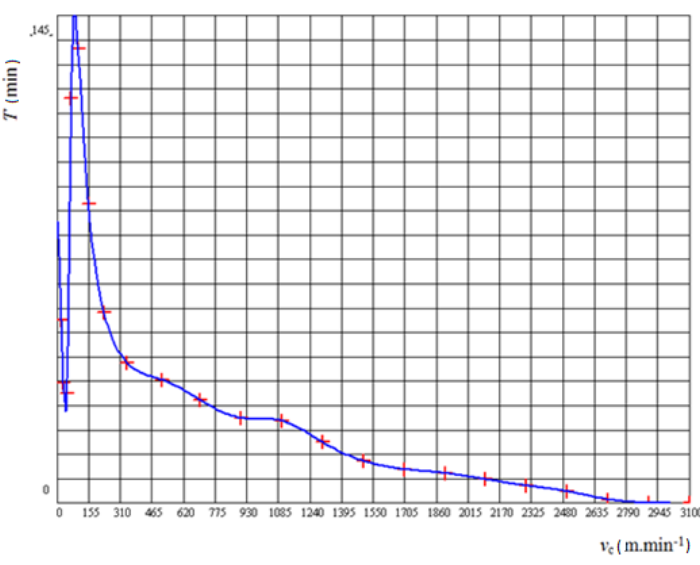
Figure 17. T-vc dependence for P20-conventional lathe.